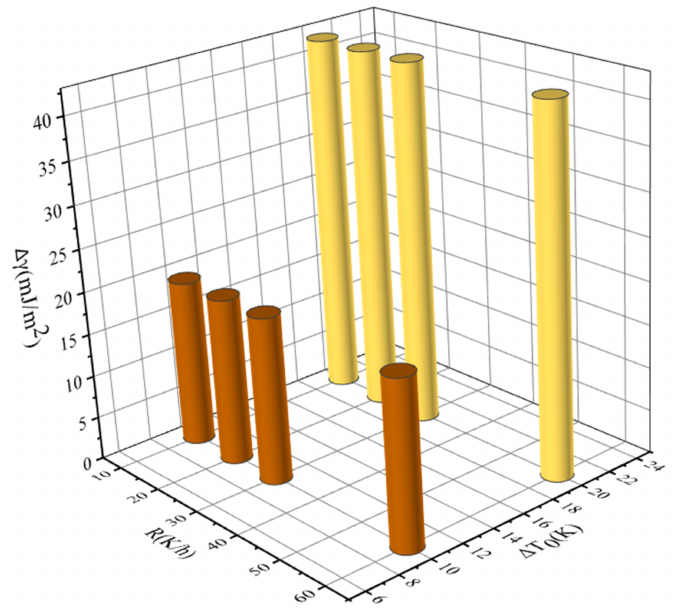
Figure 16. The relationship between interfacial energy and the change in saturated temperature (ethanol mass fraction 0.8, cooling rate 10, 20, 30, and 60 K/h, respectively).